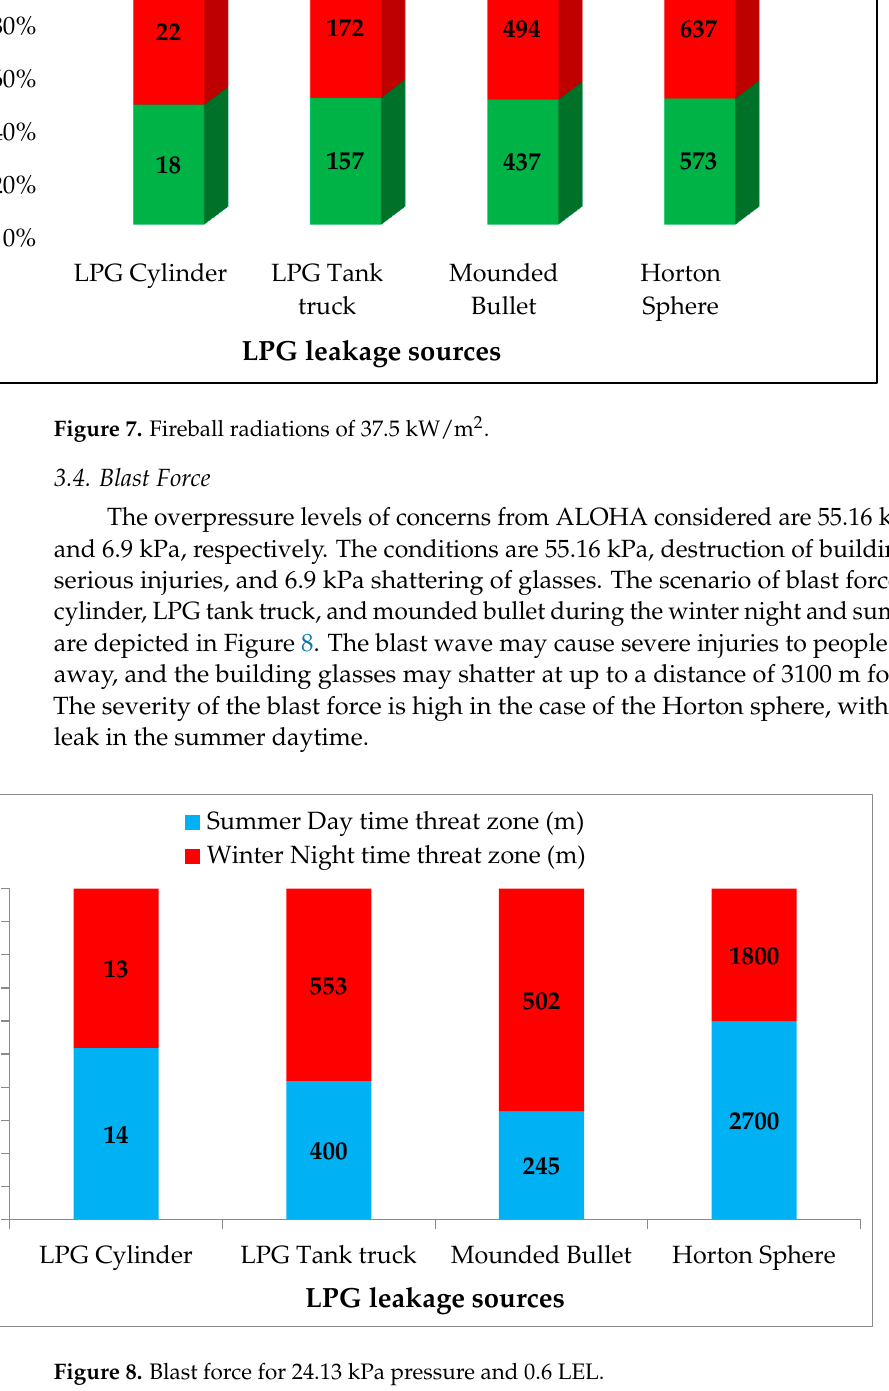
Figure 9. The dangerous flammable vapour cloud reaches the nearby residential